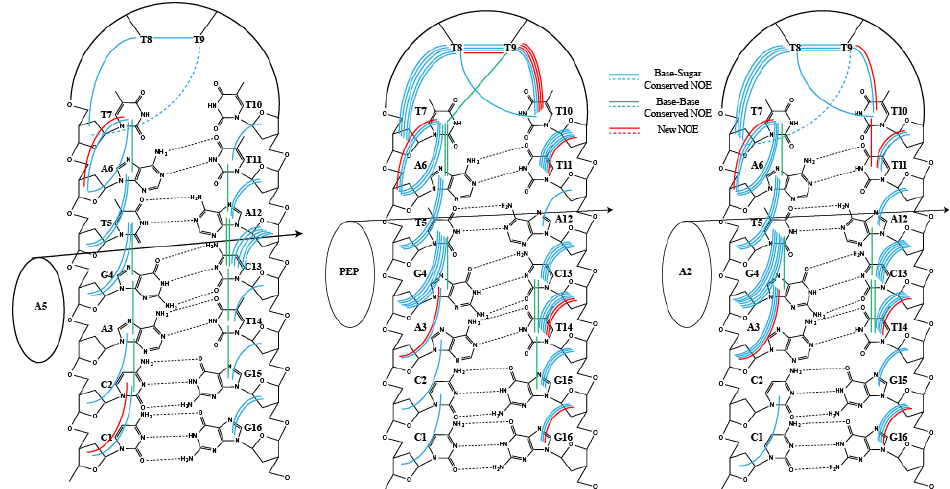
Figure 9. Overlays of the NOESY spectra for samples in D 2 O acquired at 25 °C for free OL 2 (black) and Zn(II)BLM-bound OL 2 (red). Shown here are the NOEs between the base non-exchangeable protons and their corresponding sugar protons. NOEs only detected in the presence of MBLMs are marked with primes. Magnetochemistry 2019 , 5 , x FOR PEER REVIEW